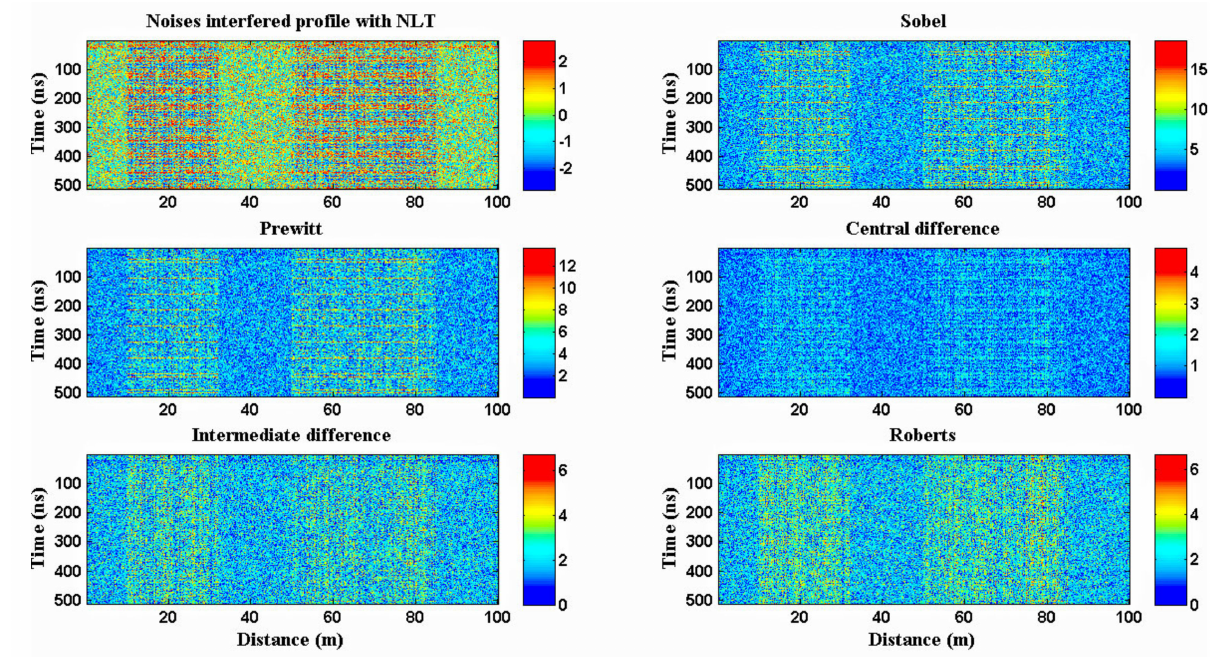
Figure 4. Two-dimensional edge maps of the hypothetical model study using various edge detectors without MDEEMD. Note that in this figure and the following, the central difference and intermediate difference indicate the Canny detector using a finite-difference scheme of central difference scheme and backward difference scheme, respectively.